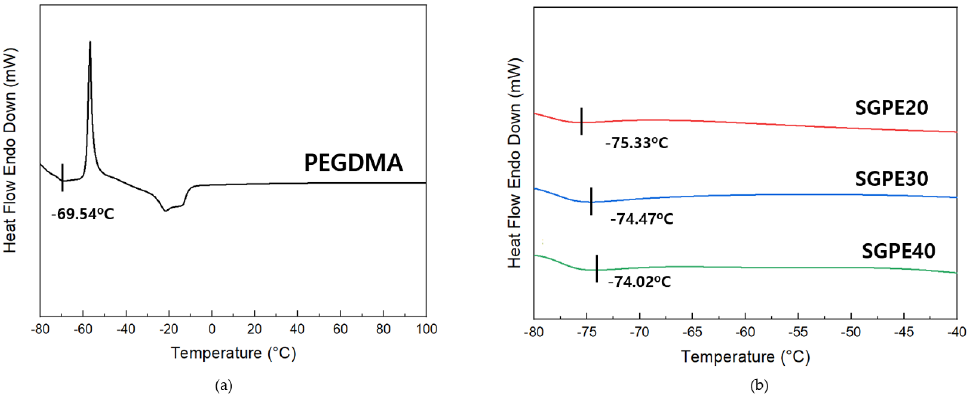
Figure 6. Glass transition temperatures of ( a ) PEGDMA and ( b ) SGPEs.